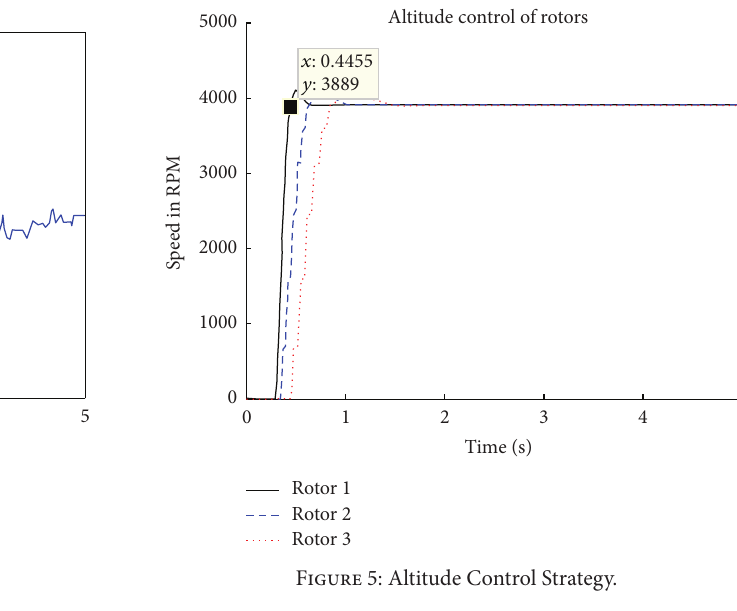
Figure 5: Altitude Control